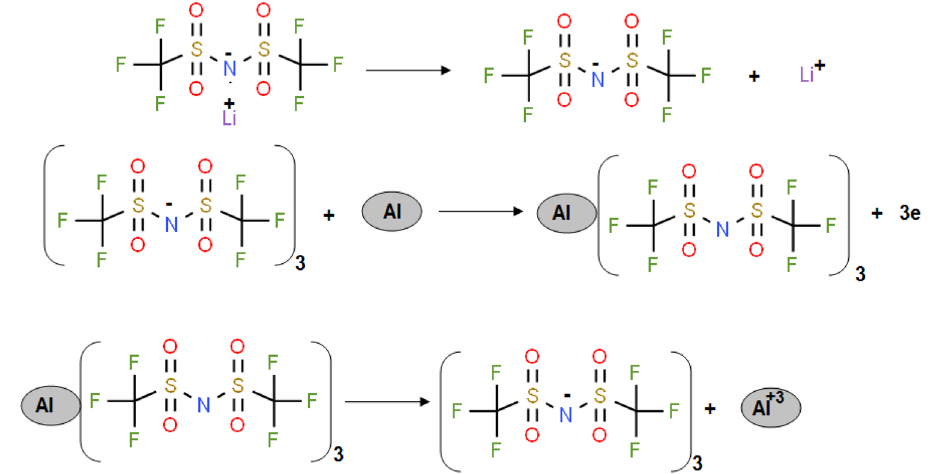
Scheme 1. The corrosion of aluminum in 1.0 M LiN(SO 2 CF 3 ) 2